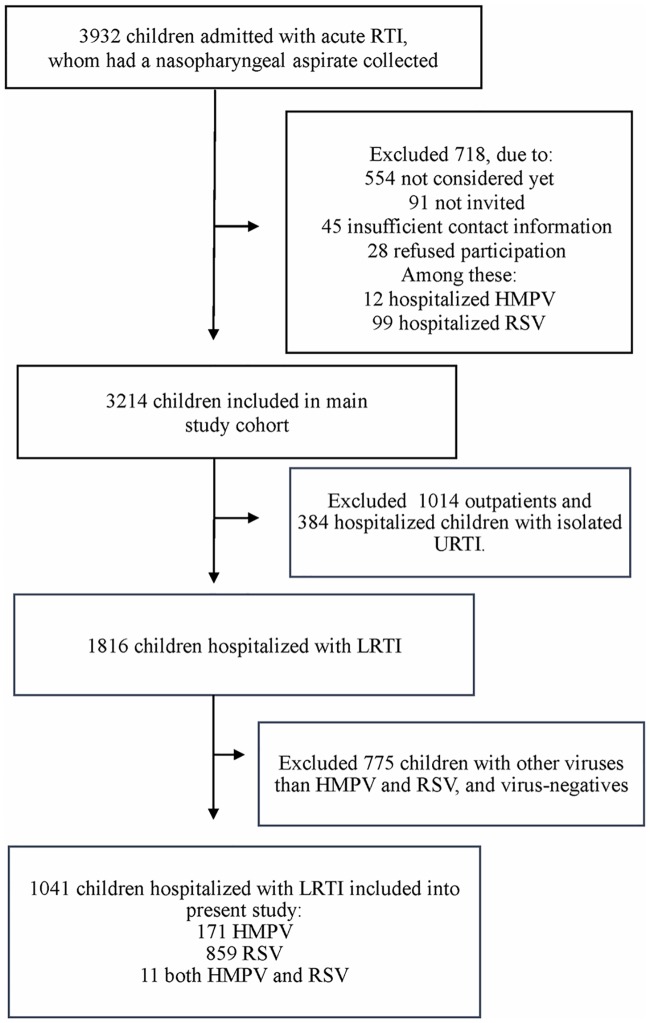
Study flow chart.Children were enrolled from the beginning of November 2006 to the end of July 2015. HMPV, human metapneumovirus; LRTI, lower respiratory tract infection; RSV, respiratory syncytial virus; RTI, respiratory tract infection; URTI, upper respiratory tract infection.